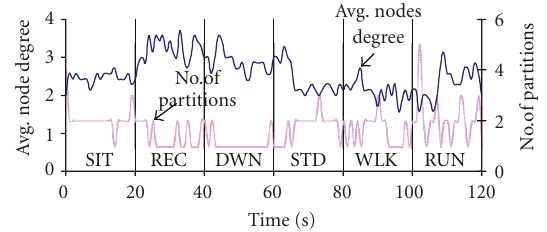
Figure 3: Instantaneous topology and partition properties with posture